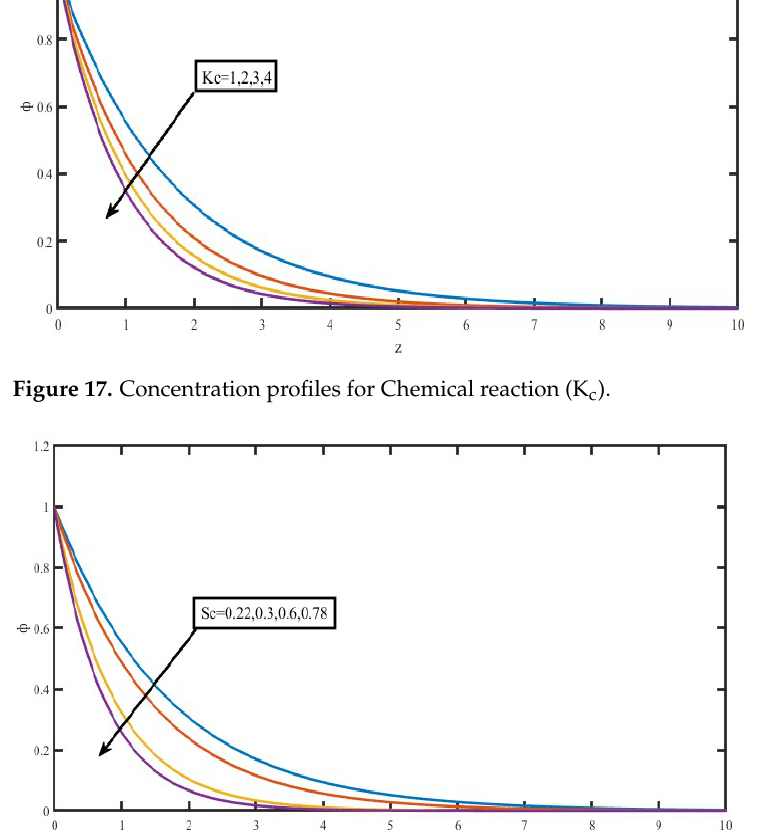
Figure 18. Concentration profiles for Schmidt number (S c ).